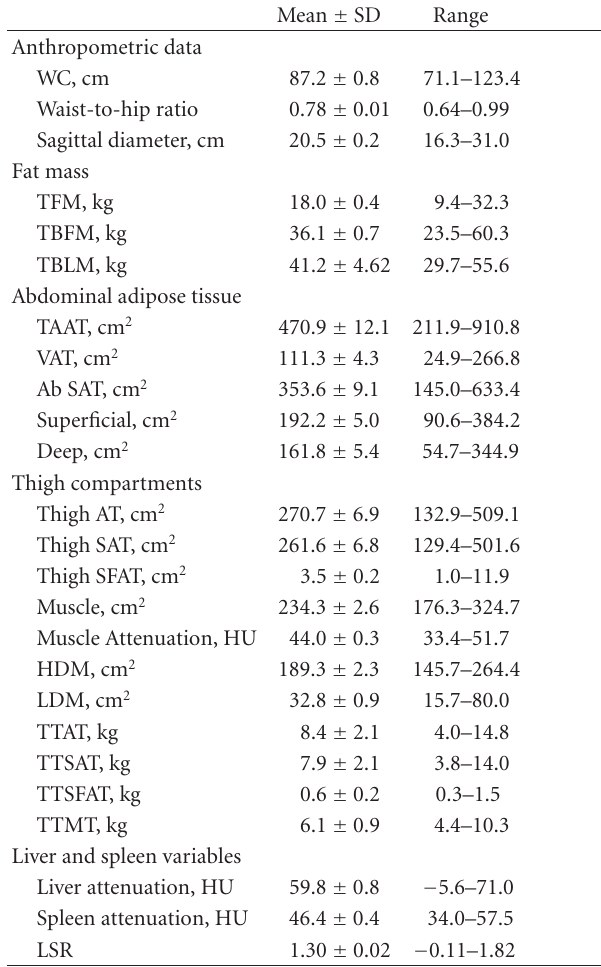
Table 1: Subjects anthropometric data, body composition data (DXA), fat and muscle distribution data (CT), and liver and spleen